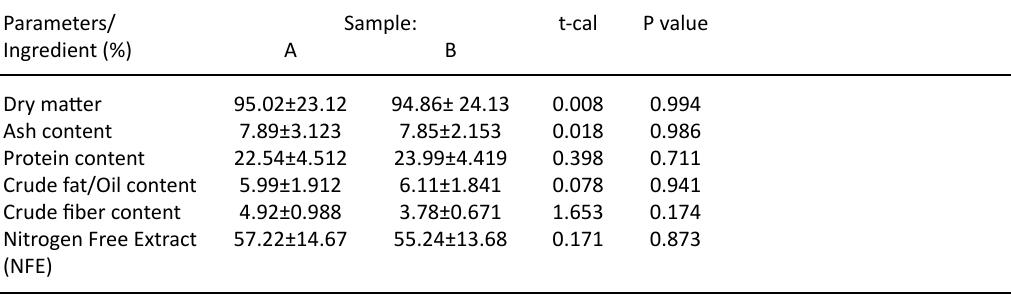
table 1. Average Proximate Composition of Selected Poultry Feeds Parameters/